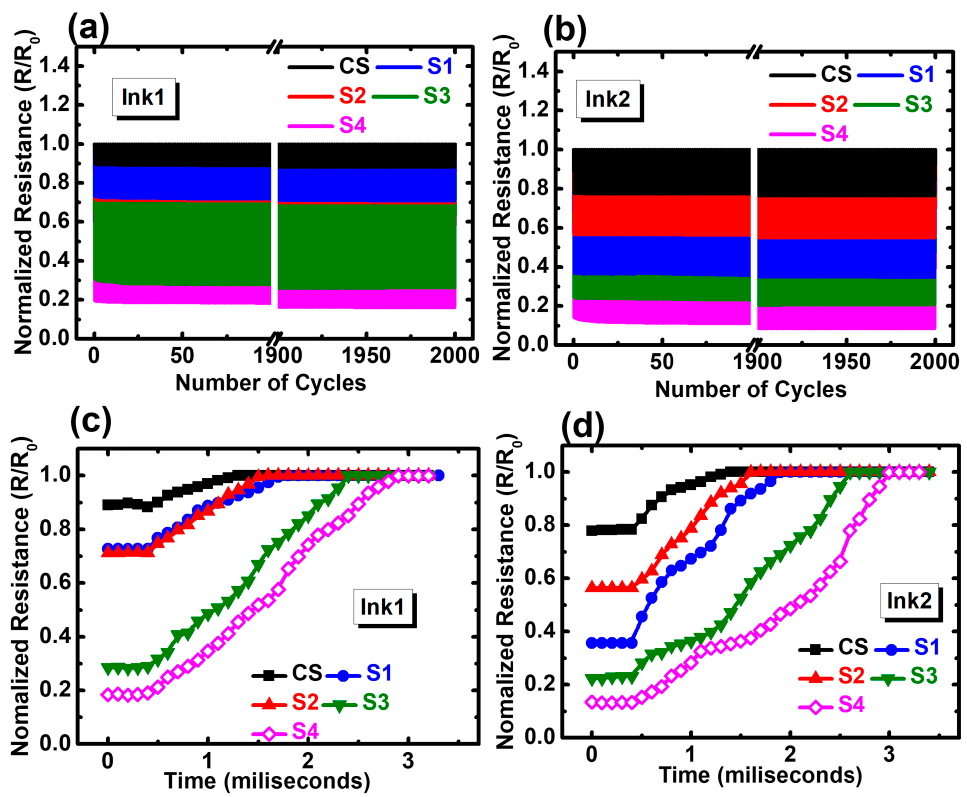
Figure 5. Reversible testing for 2000 cycles of repeated loading and unloading of 1 kPa applied pres- sure for sensors with ( a ) Ink1 and ( b ) Ink2. The time-dependent resistance characteristics for tactile sensors with ( d ) Ink1 and ( e ) Ink2.